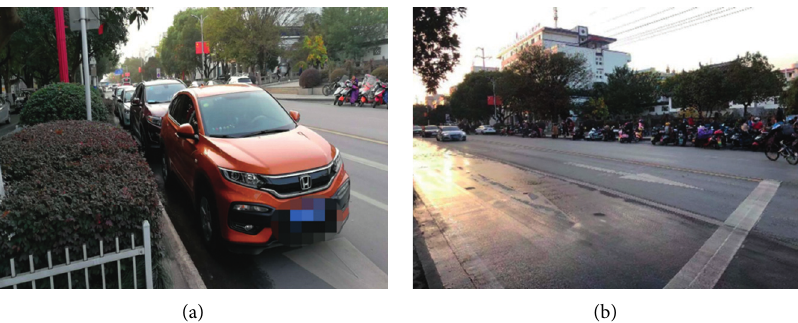
Figure 13: Field scene in front of the case school before and after fine-tuning. (a) 2019.10.17 16:30. (b) 2019.10.24 16: 30.